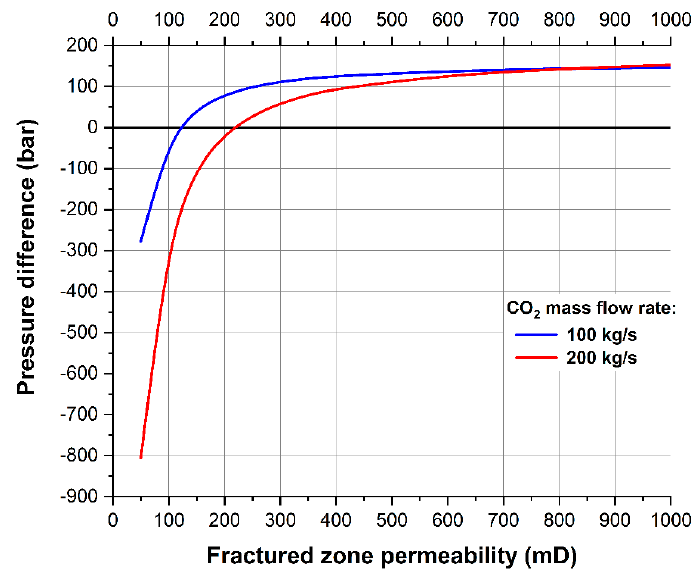
Figure 7. The impact of fractured zone permeability on the thermosiphon effect for